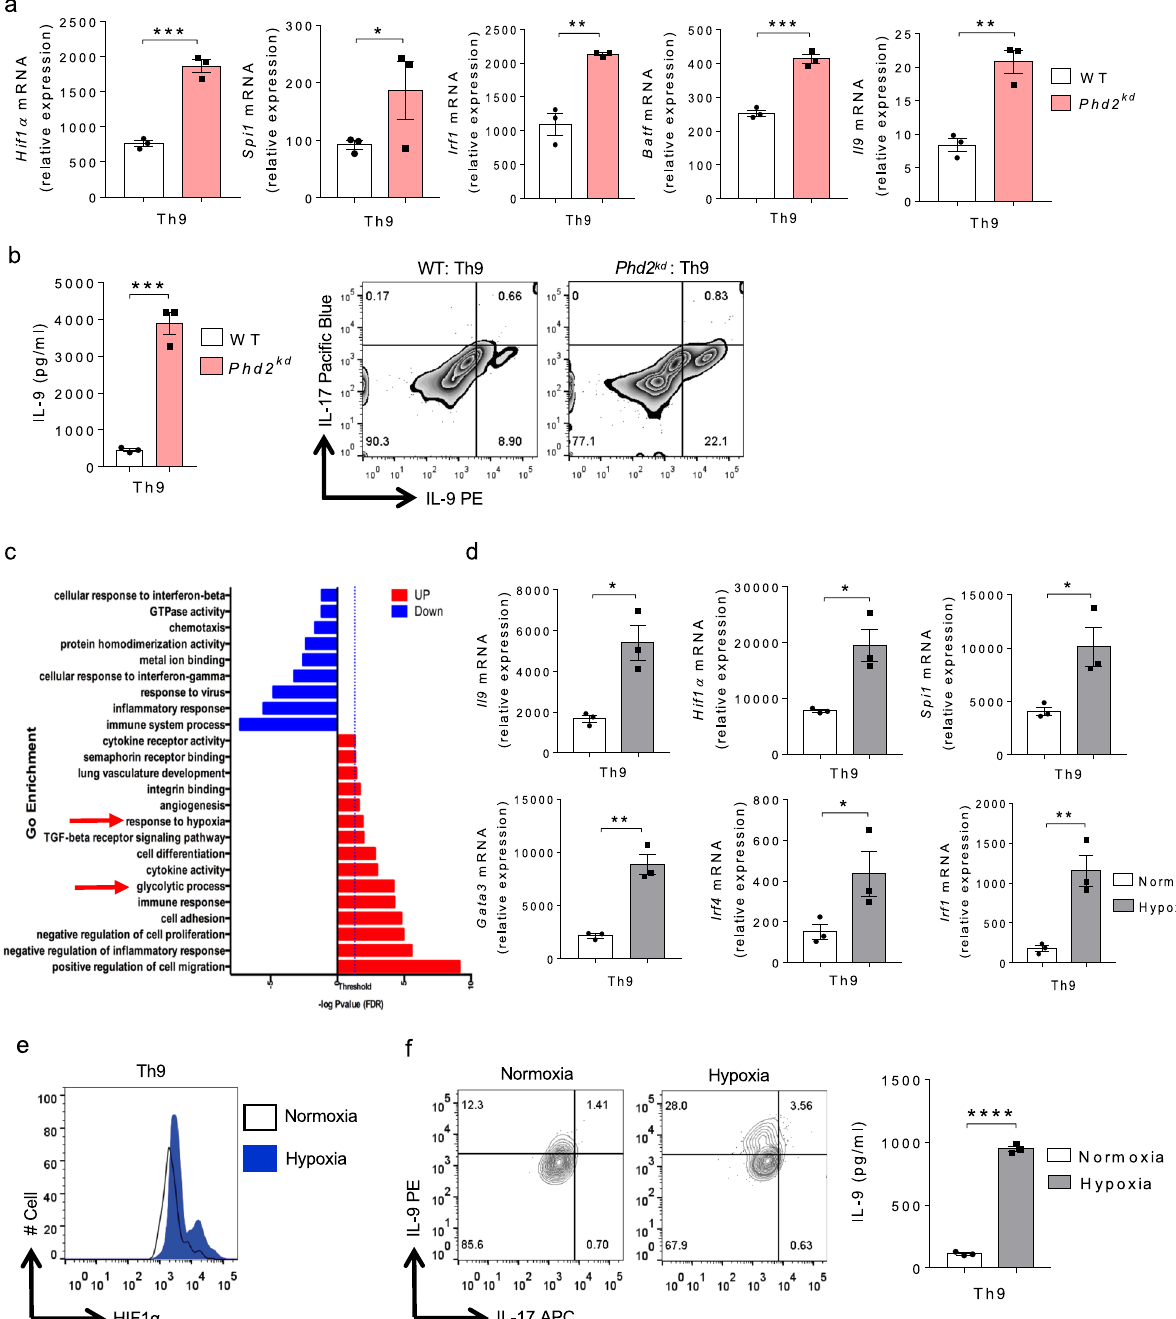
differentiated under Th9 polarizing conditions with daily treatment of 1.0 μ g/ml Dox for 3 days. a qPCR analysis of Hif1 α , Spi1, Irf1 , Batf and Il9